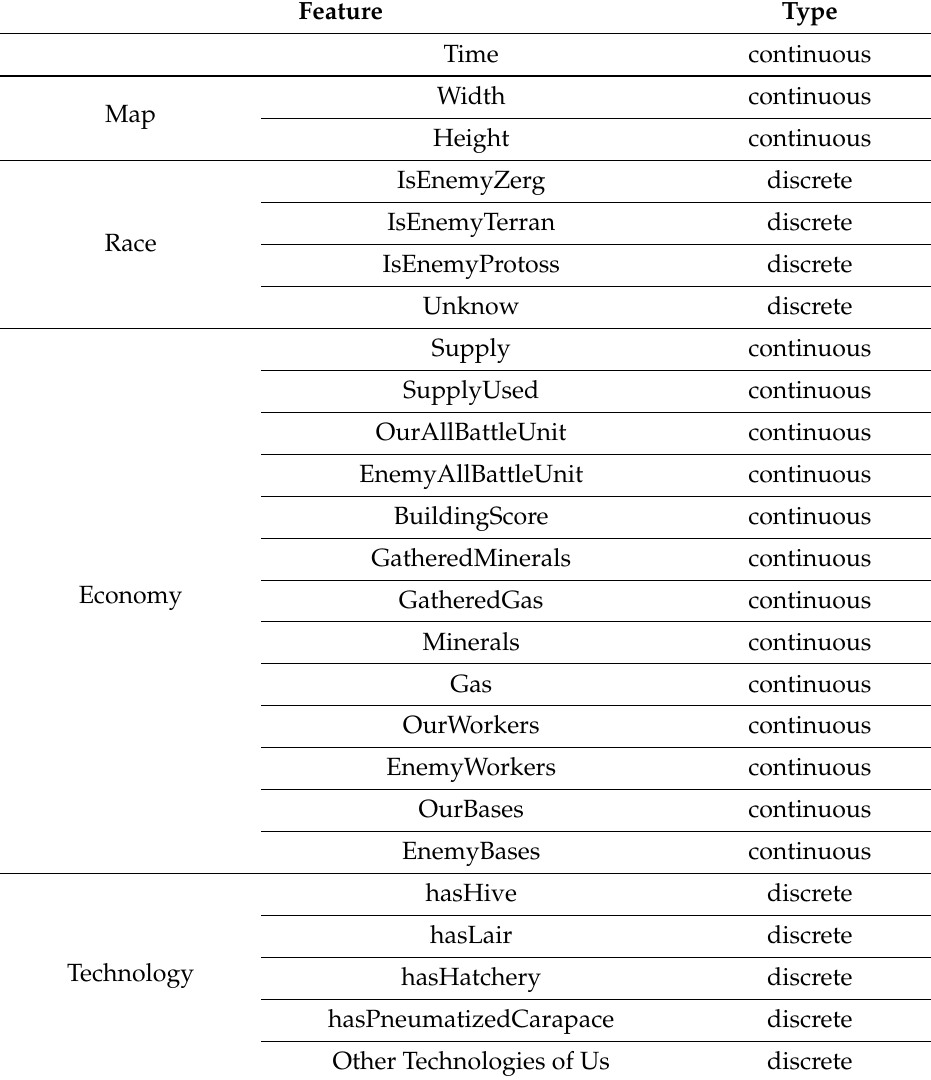
Table 2. The total raw features of